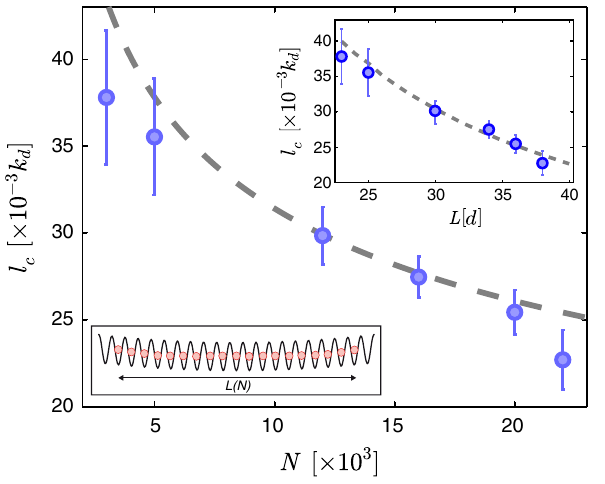
FIG. 3. Two-body correlation length. Correlation length l plotted as a function of the total atom number N in the Mott state. The dashed line is the theoretical prediction from 3D numerical calculations without adjustable parameters. Inset: l a function of the calculated in-trap total size L . The dashed line is the same numerical calculation as that in the main panel.